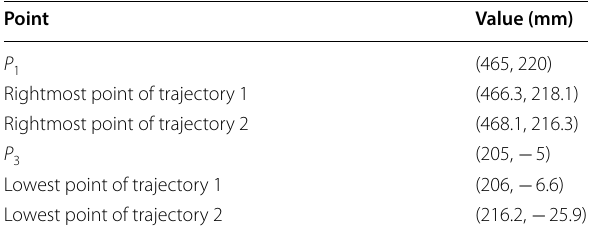
Table 2 Spatial coordinates of the two extreme pose